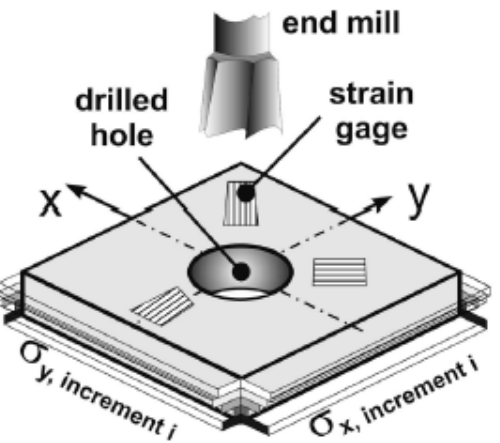
Figure 3. Schematic diagram highlighting the principle of the HDM, recompiled from [22].